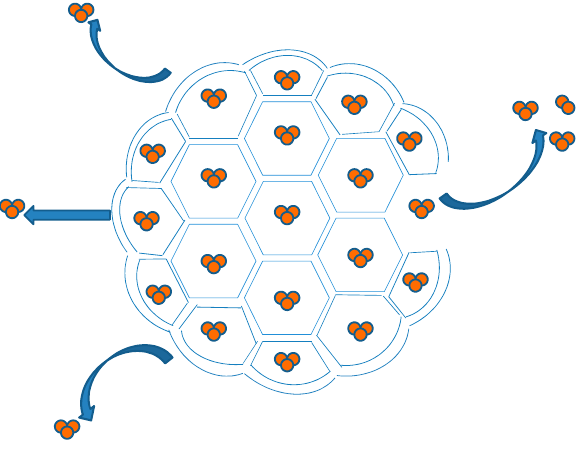
Figure 4. Spheroid and granular structure of a DepoFoam™ particle.